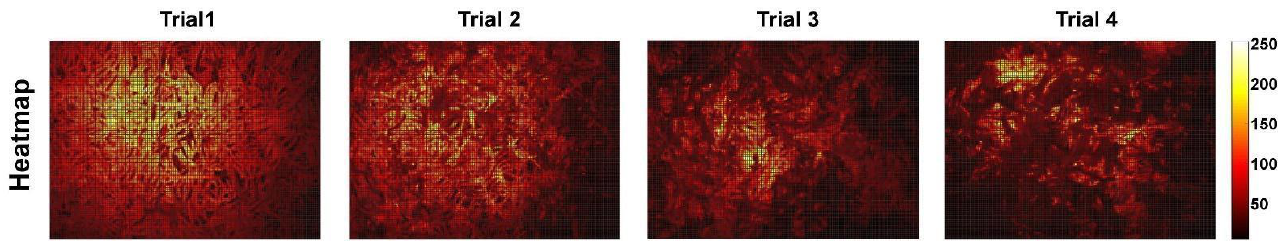
Figure 6. Histograms of RGB colors from moss LIF images taken using the green and UV lasers together, separated by trials matching Cu doses indicated in Table 1.